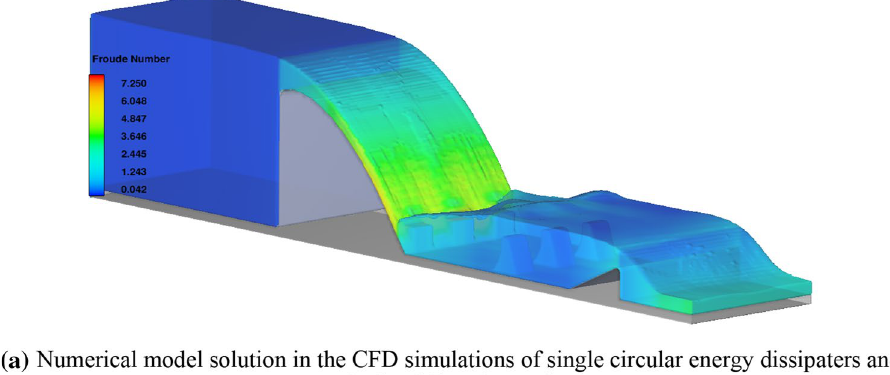
Fig. 12 Numerical model